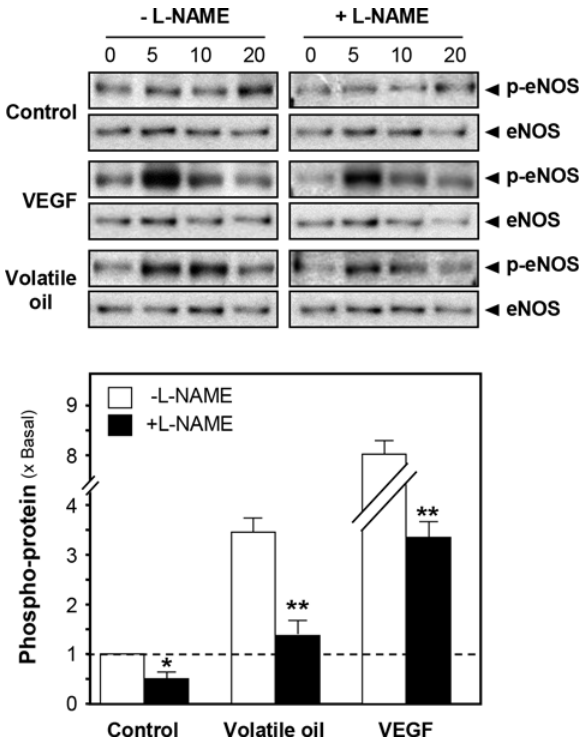
Figure 3. Phosphorylation of eNOS by NRR volatile oil in cultured HUVEC cells. Cultured HUVECs were pre-treated with serum free medium or L-NAME (100 µ M) for 3 hours, and treated with NRR volatile oil (25 µ g/mL), VEGF (10 ng/mL, positive control) or control (serum free medium) for different time points (0 to 20 min). Phospho-eNOS Ser 1177 (~135 kDa) and total eNOS (~135 kDa) were revealed by using specific antibodies (upper panel). Quantification of phospho-eNOS protein (at 5 min) from the blot was calculated by a densitometer (lower panel). Data were expressed as x Basal where the control (untreated culture) was set as 1, Mean ± SEM, n = 4, each with triplicate samples. ** p < 0.01.